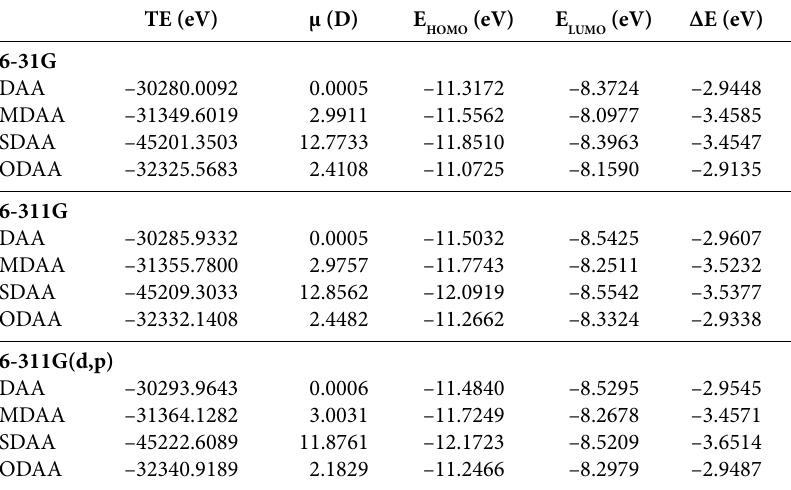
Table 3: Calculated quantum chemical descriptors for protonated molecules in gas phase.